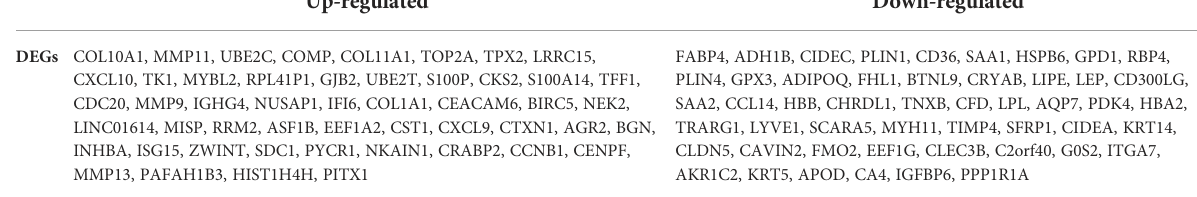
TABLE 1 Identi fi cation of top 100 DEGs between breast cancer and normal